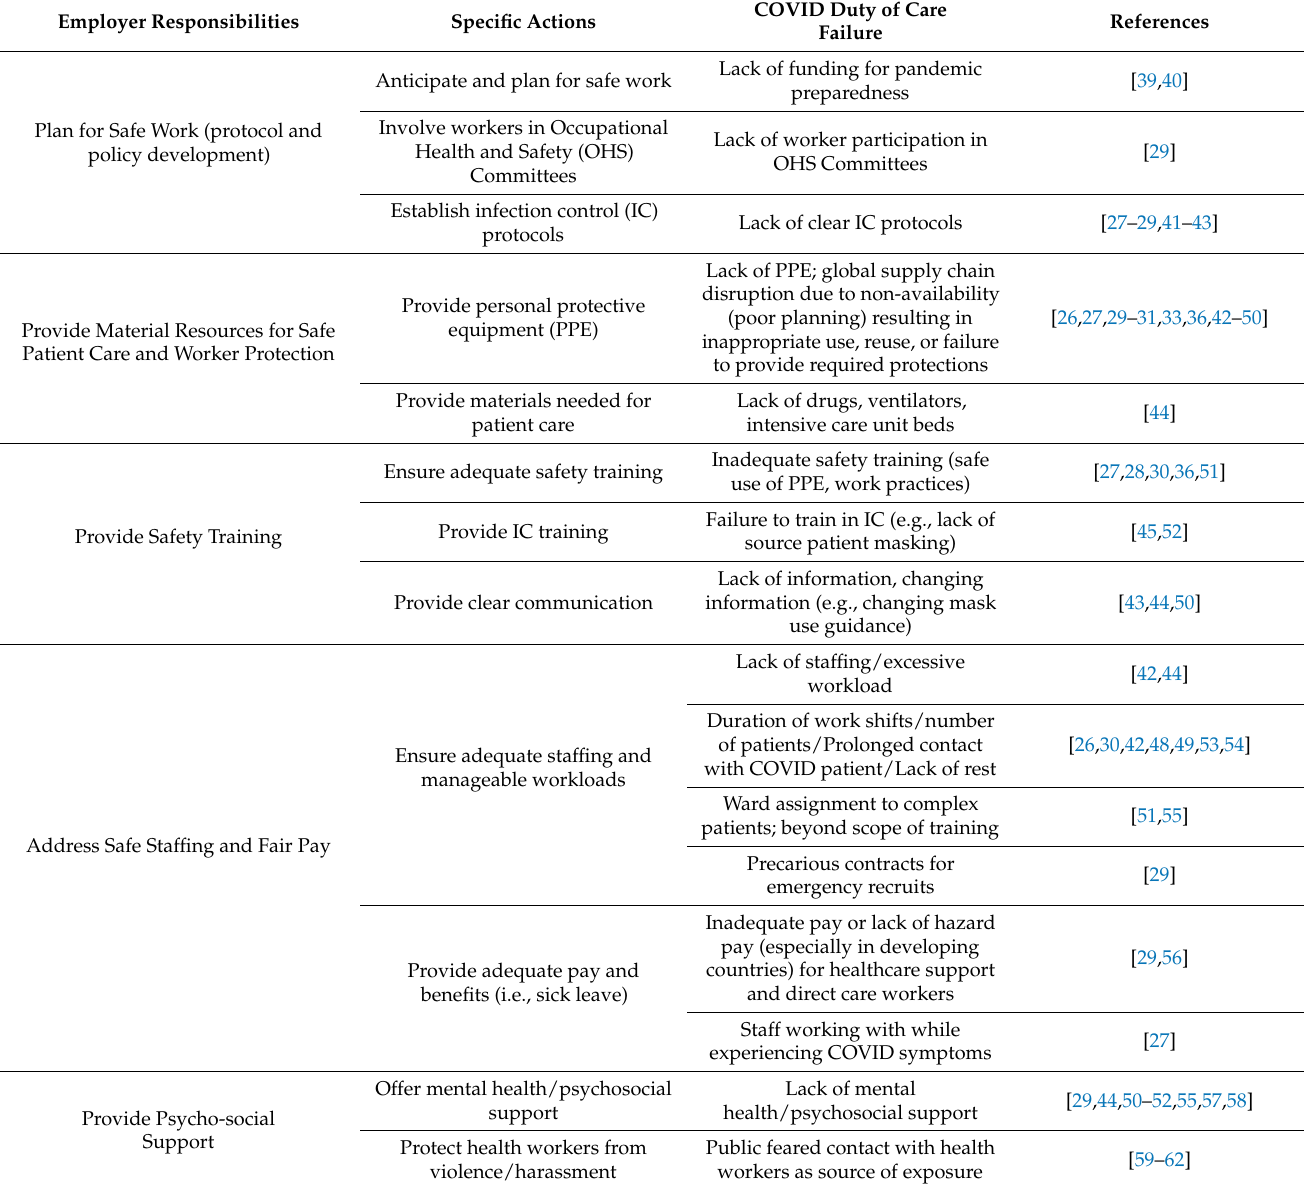
Table 1. Selected examples of duty of care failures in COVID